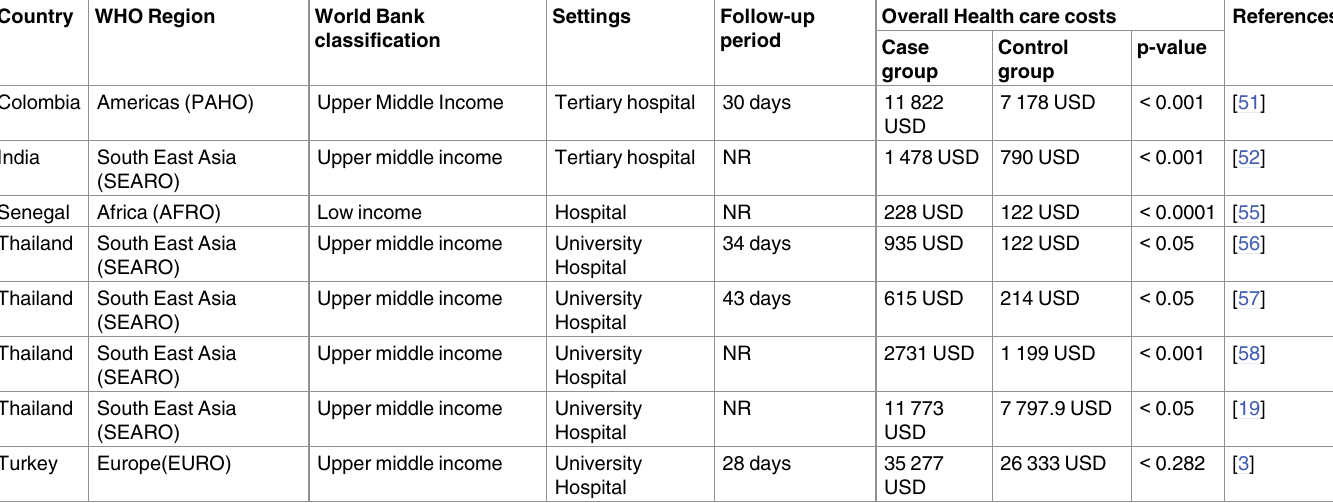
Table 4. Summaryof data on health care costs associated with resistant infections.